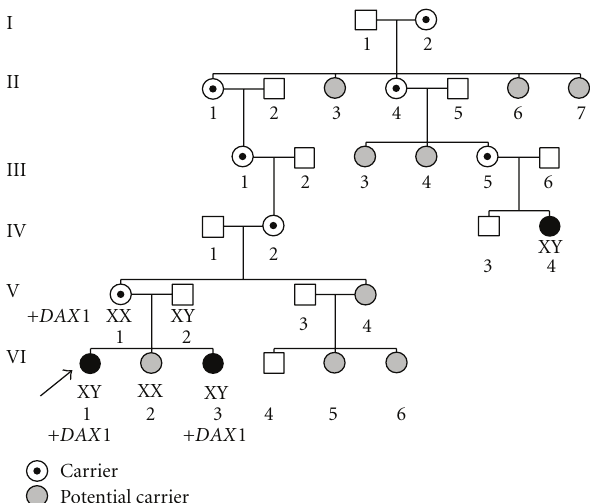
Figure 1: Family pedigree. Pedigree of a family with two sisters with 46,XY gonadal dysgenesis. +DAX1 indicates the subjects that carry the X chromosome containing the NR0B1 locus duplication. XX and XY have been added underneath some subjects indicating a 46,XX or 46,XY karyotype, respectively. Mandatory female carriers and potential carriers are